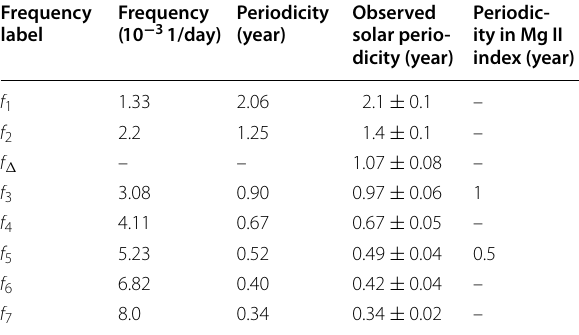
Table 1 The first seven primary frequency components of U ( 1 ) and corresponding periodicities (in year) of the Sun (Polygiannakis et al. 2003) and Mg II Index (Hocke 2008) Frequency